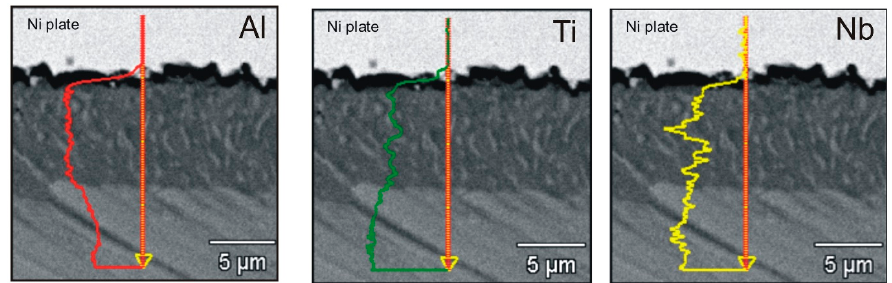
Figure 7. Linear distribution of Al, Ti, and Nb of cross-section of Ti–45Al–8Nb–0.5(B, C) alloy modified aluminium coating.